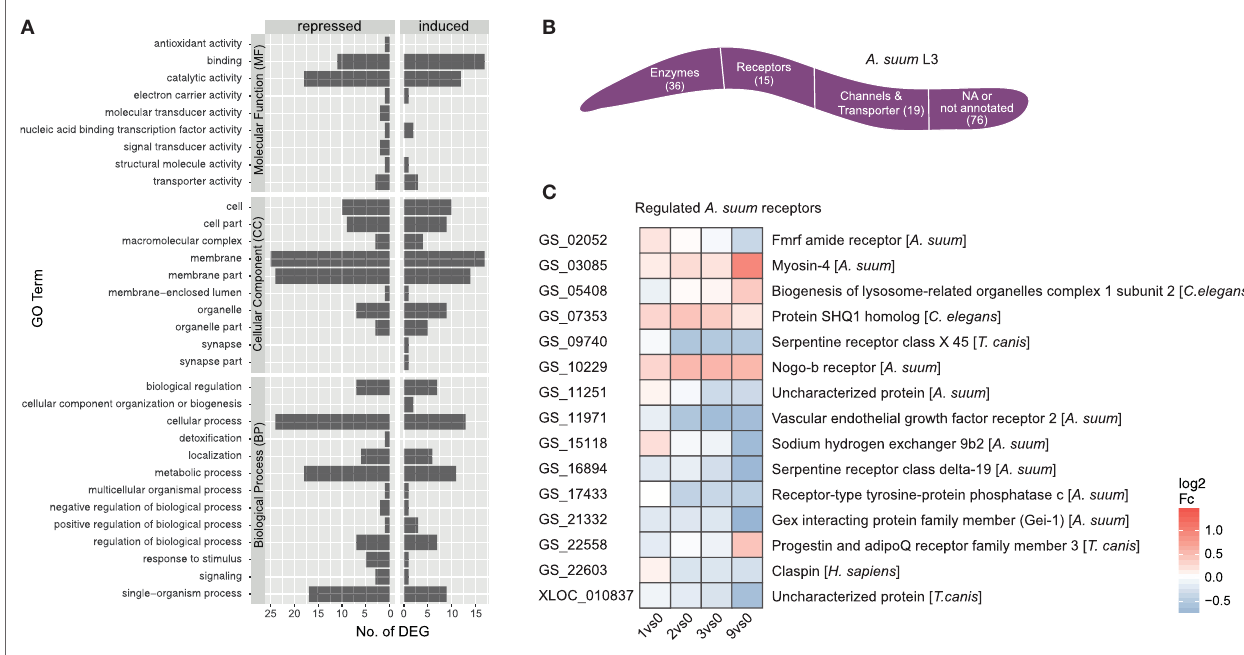
FigUre 5 | Gene ontology (GO) profiling of Ascaris suum differentially expressed genes (DEGs). (a) Distribution of level 2 GO terms for A. suum L3 DEGs, categorized into molecular function, cellular component (CC), and biological process (BP). (B) Global classification of A. suum L3 DEGs into enzymes, receptors, and channels/transporter based on GO-term filter and gene description analysis (Table S3 in Supplementary Material). (c) Time-resolved expression of A. suum DEGs with GO assigned receptor